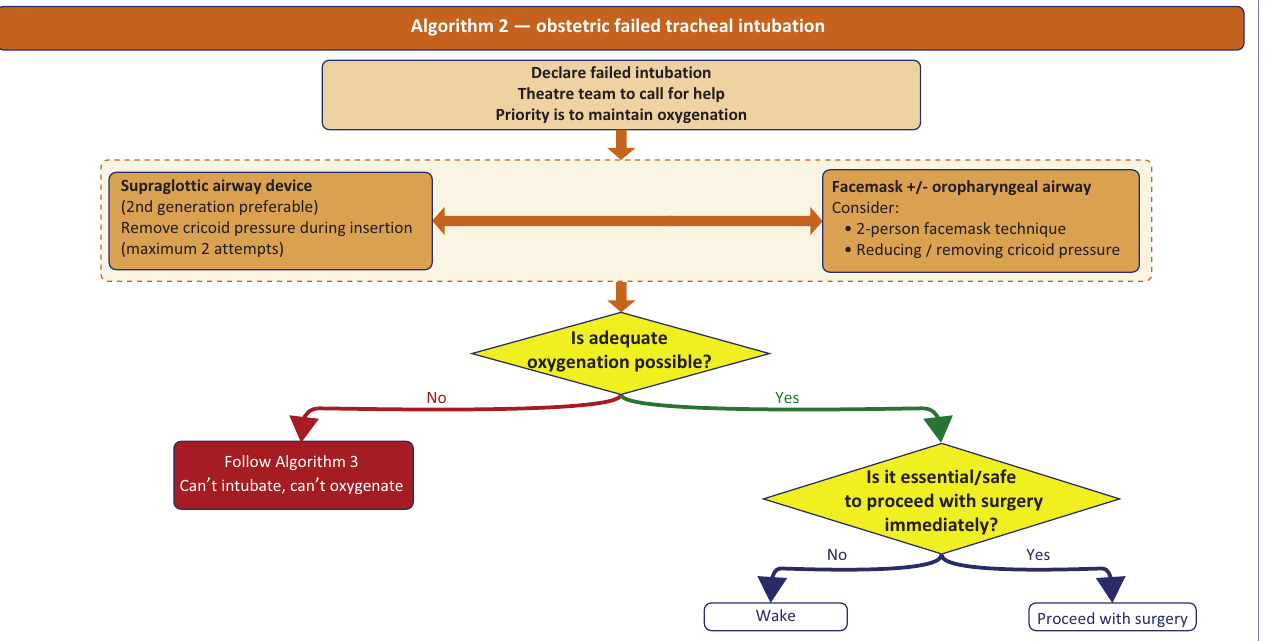
FIGURE 3: Obstetric failed tracheal intubation.